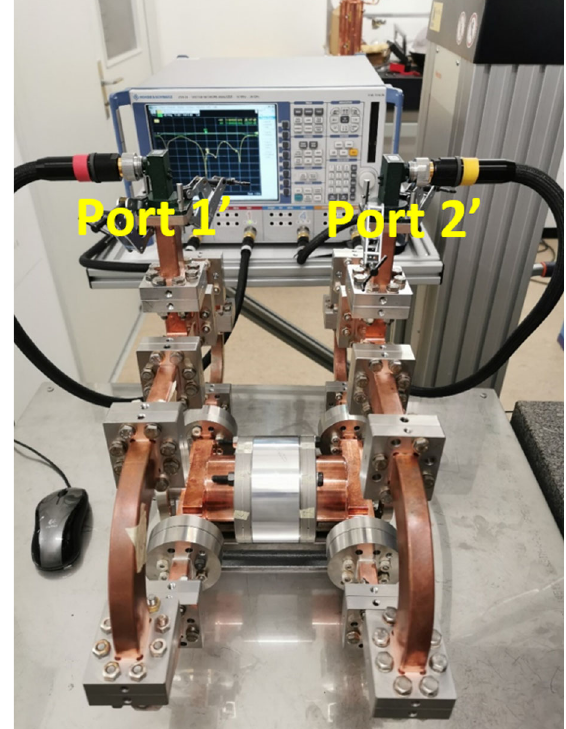
II).FIG. 20. Measured electric field magnitude for injecting rf power from ports 1 and 3 (a), and from ports 2 and 4 (b),